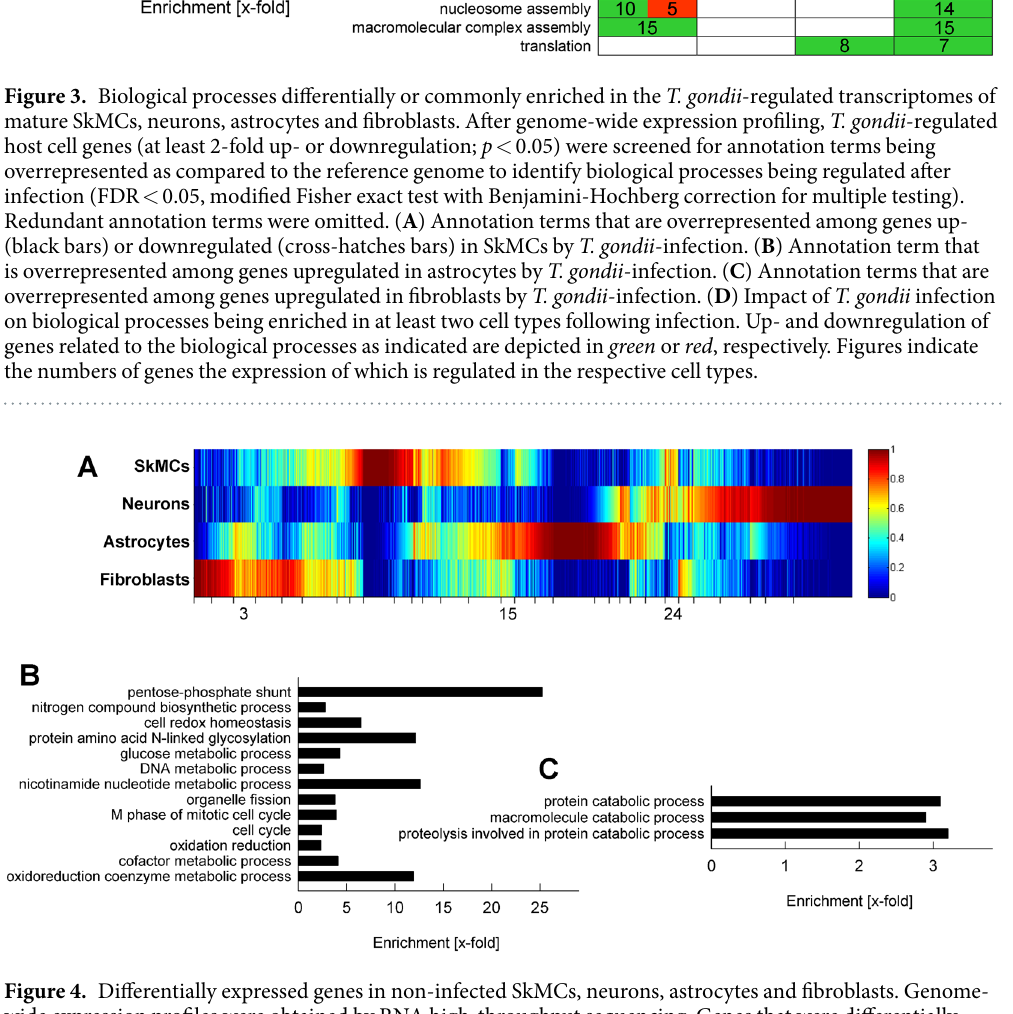
Figure 4. Differentially expressed genes in non-infected SkMCs, neurons, astrocytes and fibroblasts. Genome- wide expression profiles were obtained by RNA high-throughput sequencing. Genes that were differentially expressed between cell types were extracted (Chi 2 test, FWER < 0.01). ( A ) Heat map of DEGs from SkMCs, neurons, astrocytes and fibroblasts. Expression profiles were clustered according to a one-dimensional self- organizing map. Gene clusters that were differentially expressed in SkMCs and neurons as compared to astrocytes and fibroblasts are indicated by cluster numbers. ( B , C ) Biological processes showing differential gene expression profiles between SkMCs and neurons as compared to astrocytes and fibroblasts. Annotation terms that were overrepresented among the genes from cluster 3 ( B) and cluster 24 (C ) as compared to the reference genome were identified by GO analysis (FDR < 0.05, modified Fisher exact test with Benjamini-Hochberg correction for multiple testing). Redundant annotation terms were